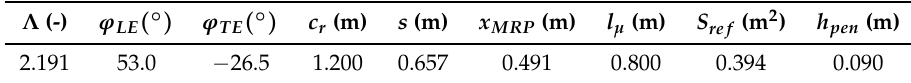
Figure 1. AVT-183 diamond wing model: ( a ) mounted in the test section and ( b ) draft. Table 1. Wing planform